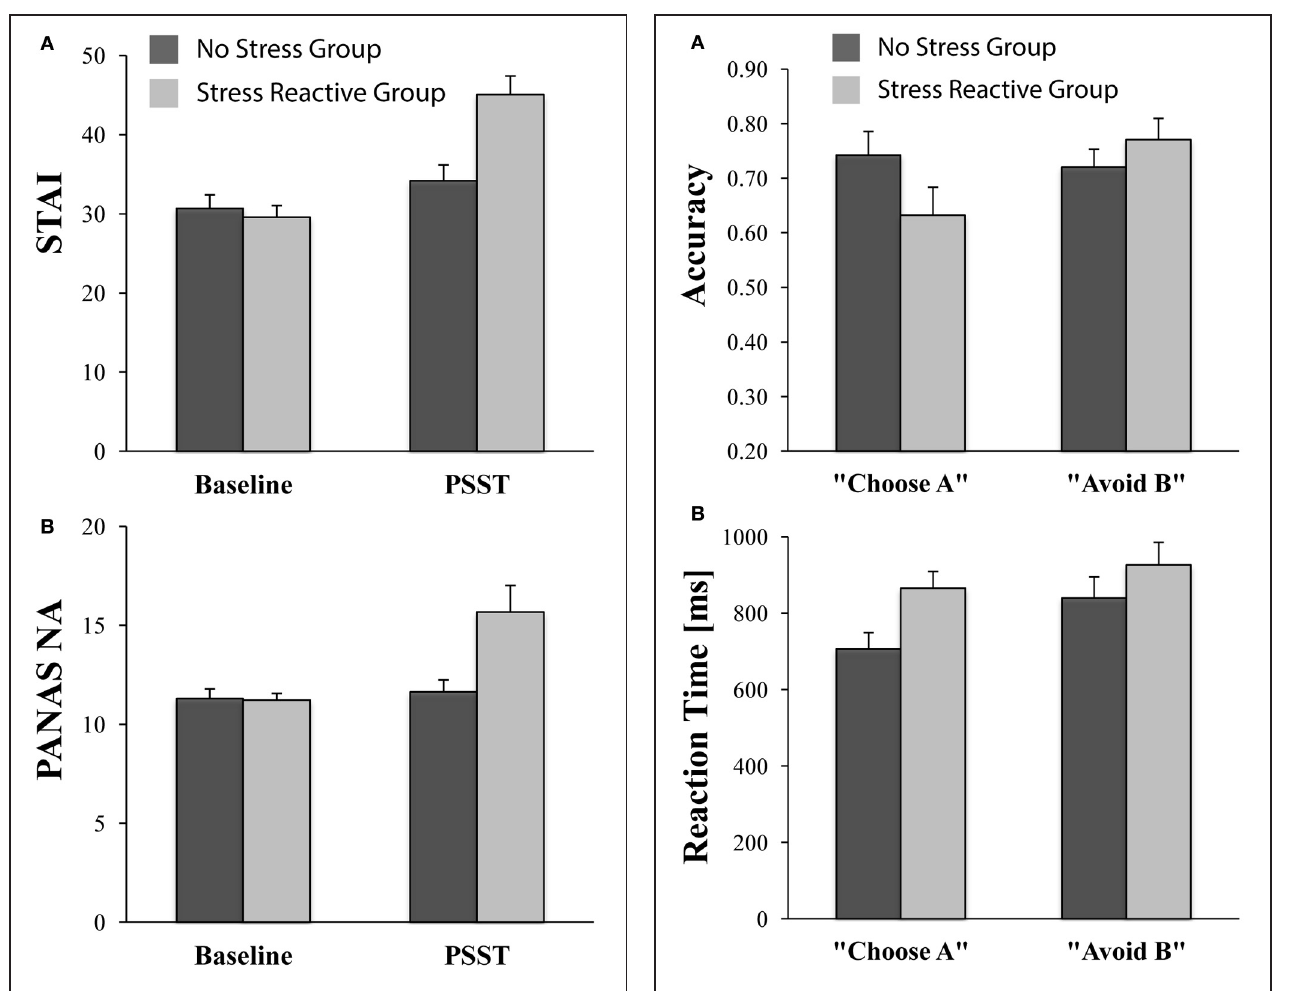
FIGURE 3 | Affective ratings in the no-stress ( n = 27) and stress-reactive ( n = 18) groups at baseline and during the PSST. (A) State Trait Anxiety Inventory (STAI) scores; and (B) Negative Affect score on the Positive and Negative Affect Schedule (PANAS). For both scales, the state version was used.